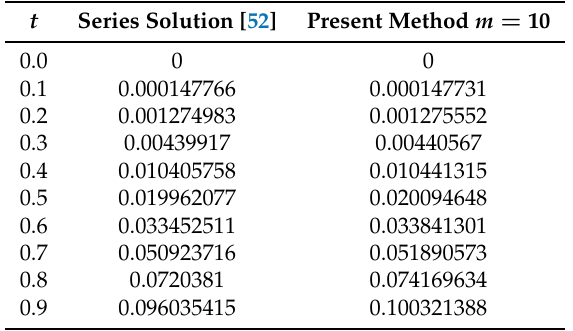
Table 3. Comparison of numerical solution with series solution for Example 3.